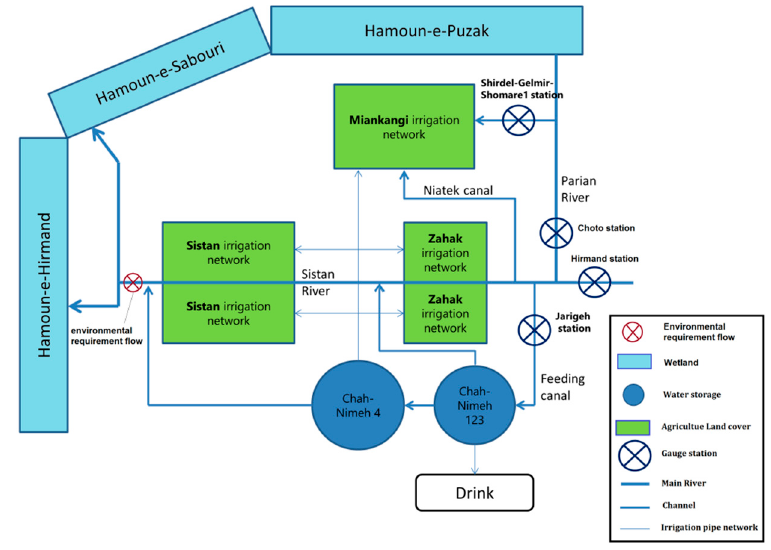
Figure 2. Schematic model of the water system in Sistan region, Iran.